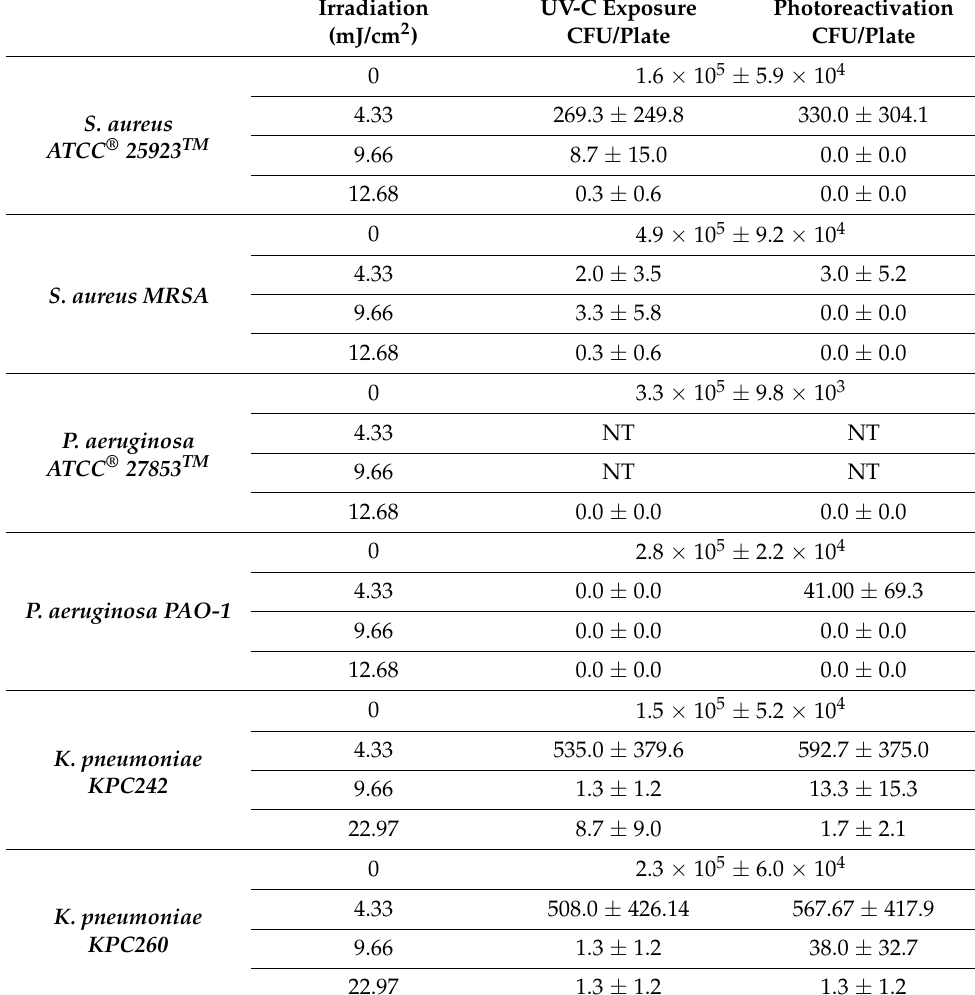
Table 2. Kinetics of bacterial inactivation and photoreactivation after in vitro UV-C irradiation.